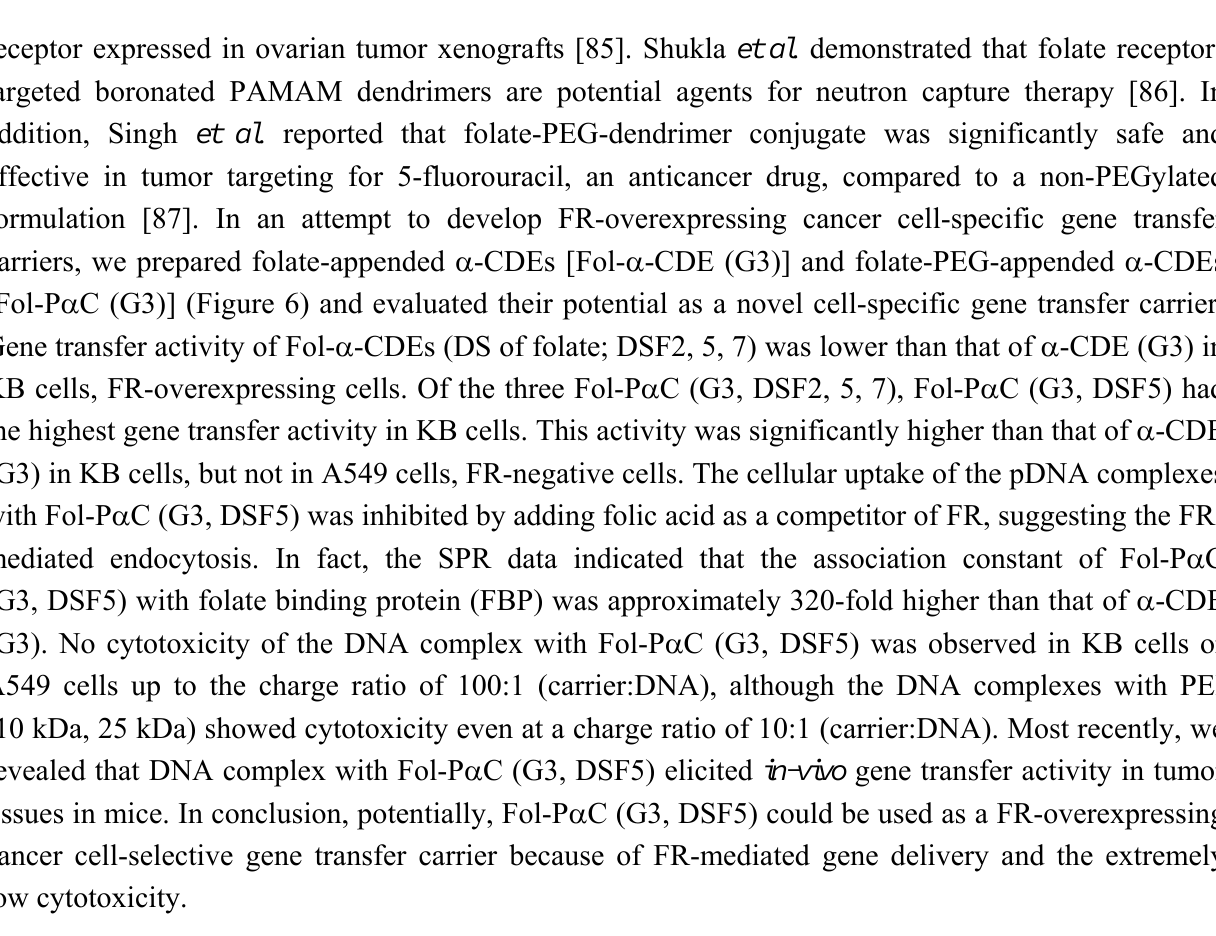
Figure 6. Chemical structures of α -CDE (G3), Fol- α -CDE (G3) and Fol-P α C (G3).